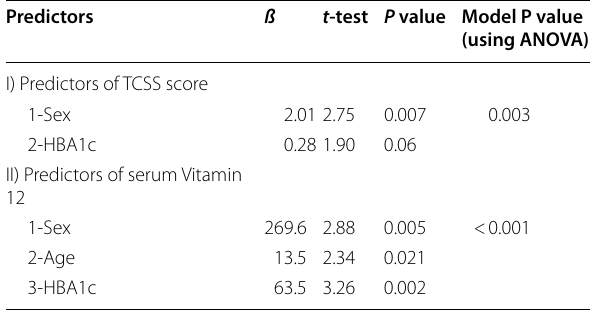
Table 4 Predictors of neuropathy score (TCSS score) and vitamin B 12—final models (stepwise linear